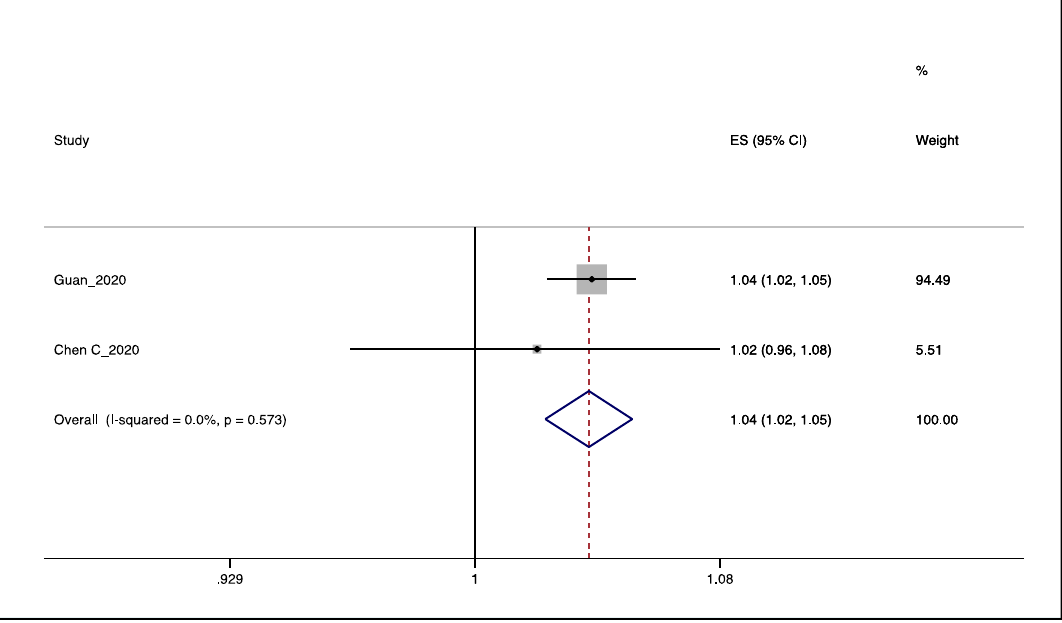
Table 6. The e ff ect of the number of age-related risk factors included in the multivariate model on the relative risk (RR) estimate for disease severity and